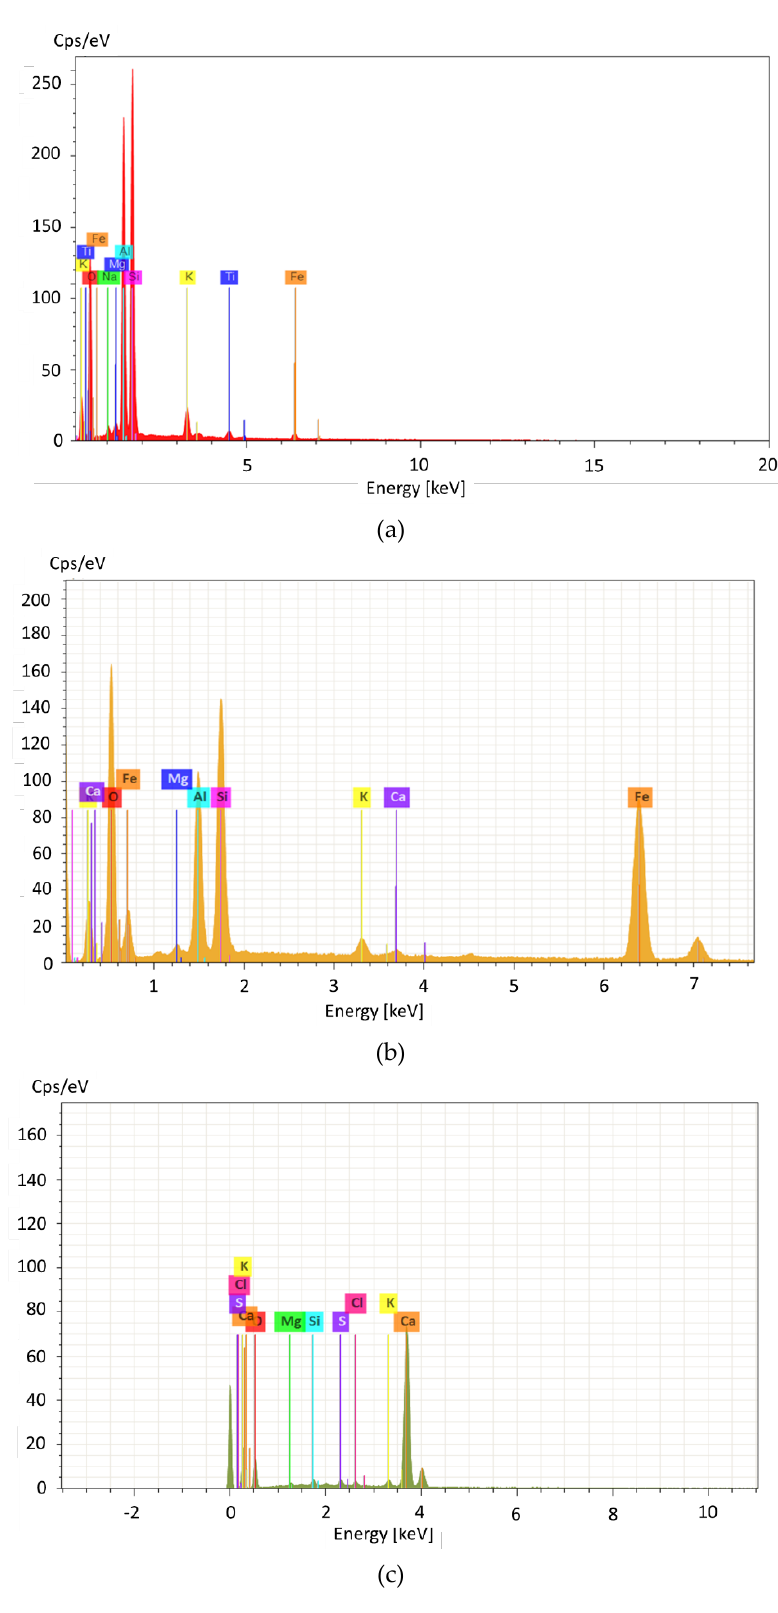
Figure 4. Examples of Espirit Spectrum Analysis for Bruker EDS: ( a ) RFA, point 42, aluminosilicate particles, ( b ) RFA, point analyzed as mullite, and ( c ) CFA, point analyzed as lime.